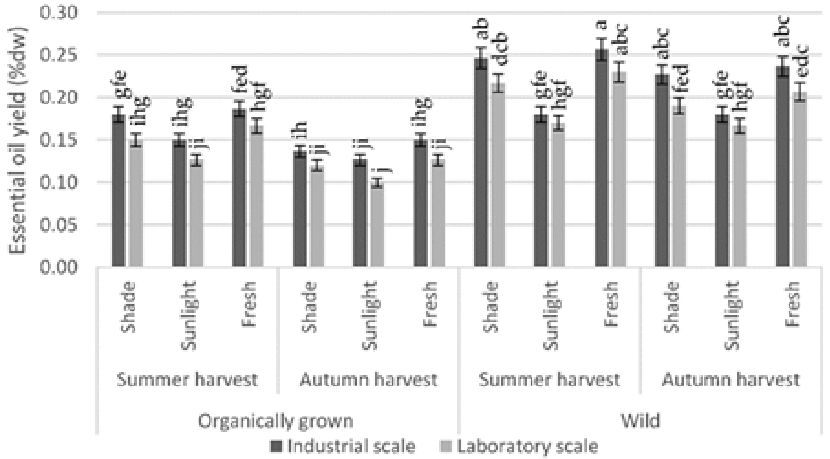
Figure 1. The influence of the analyzed factors on the essential oil yield of immortelle. (The bars designated by different small letters (a, b, c, d, e, f, g, h, i, j) are significantly different ( p < 0.05)). Table 1. Results of the analysis of the variance of the influence of the analyzed factors on the content of the essential oils in immortelle at a significance level of p < 0.05.